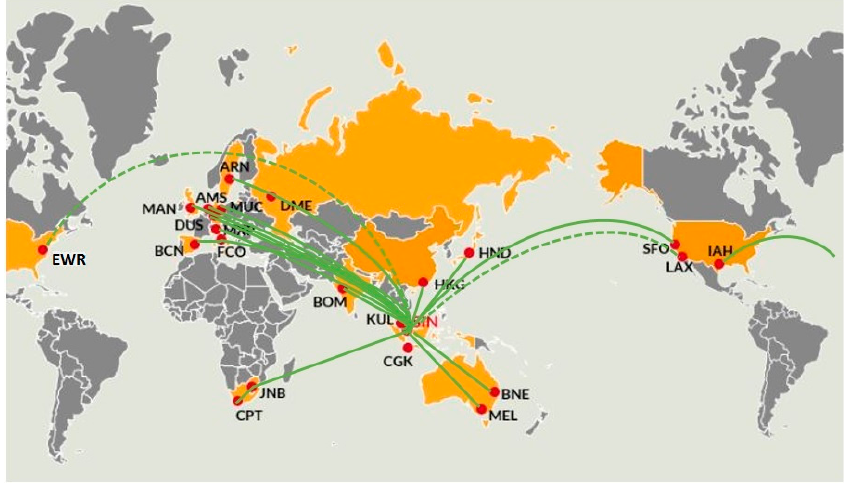
Figure 5. Singapore Airlines Airbus A350-900XWB aircraft actual and proposed routes as at 31 March 2018. Note: SIN-LAX and SIN/NYC services are proposed routes commencing in the second half of 2018. Legend: AMS = Amsterdam, ARN = Stockholm Arlanda Airport, BNE = Brisbane, BCN =